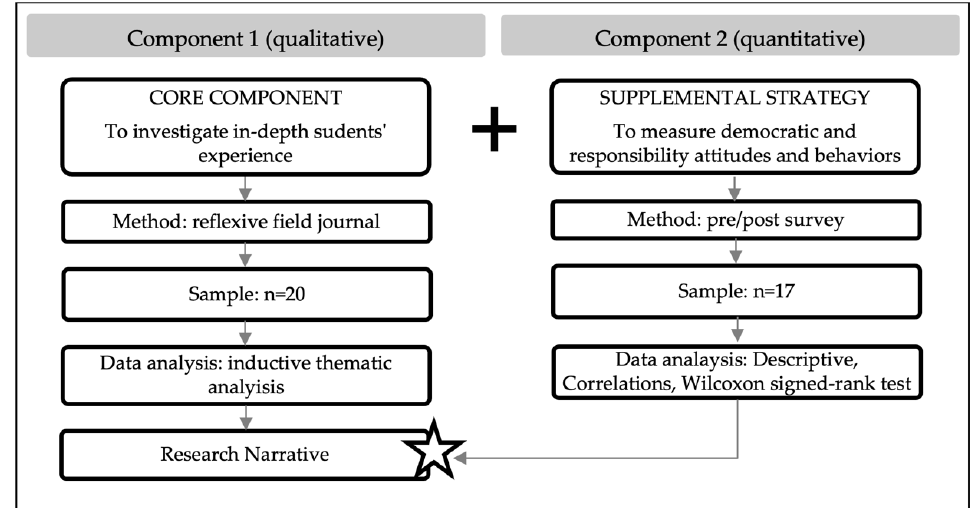
Figure 1. Simultaneous mixed-method design.